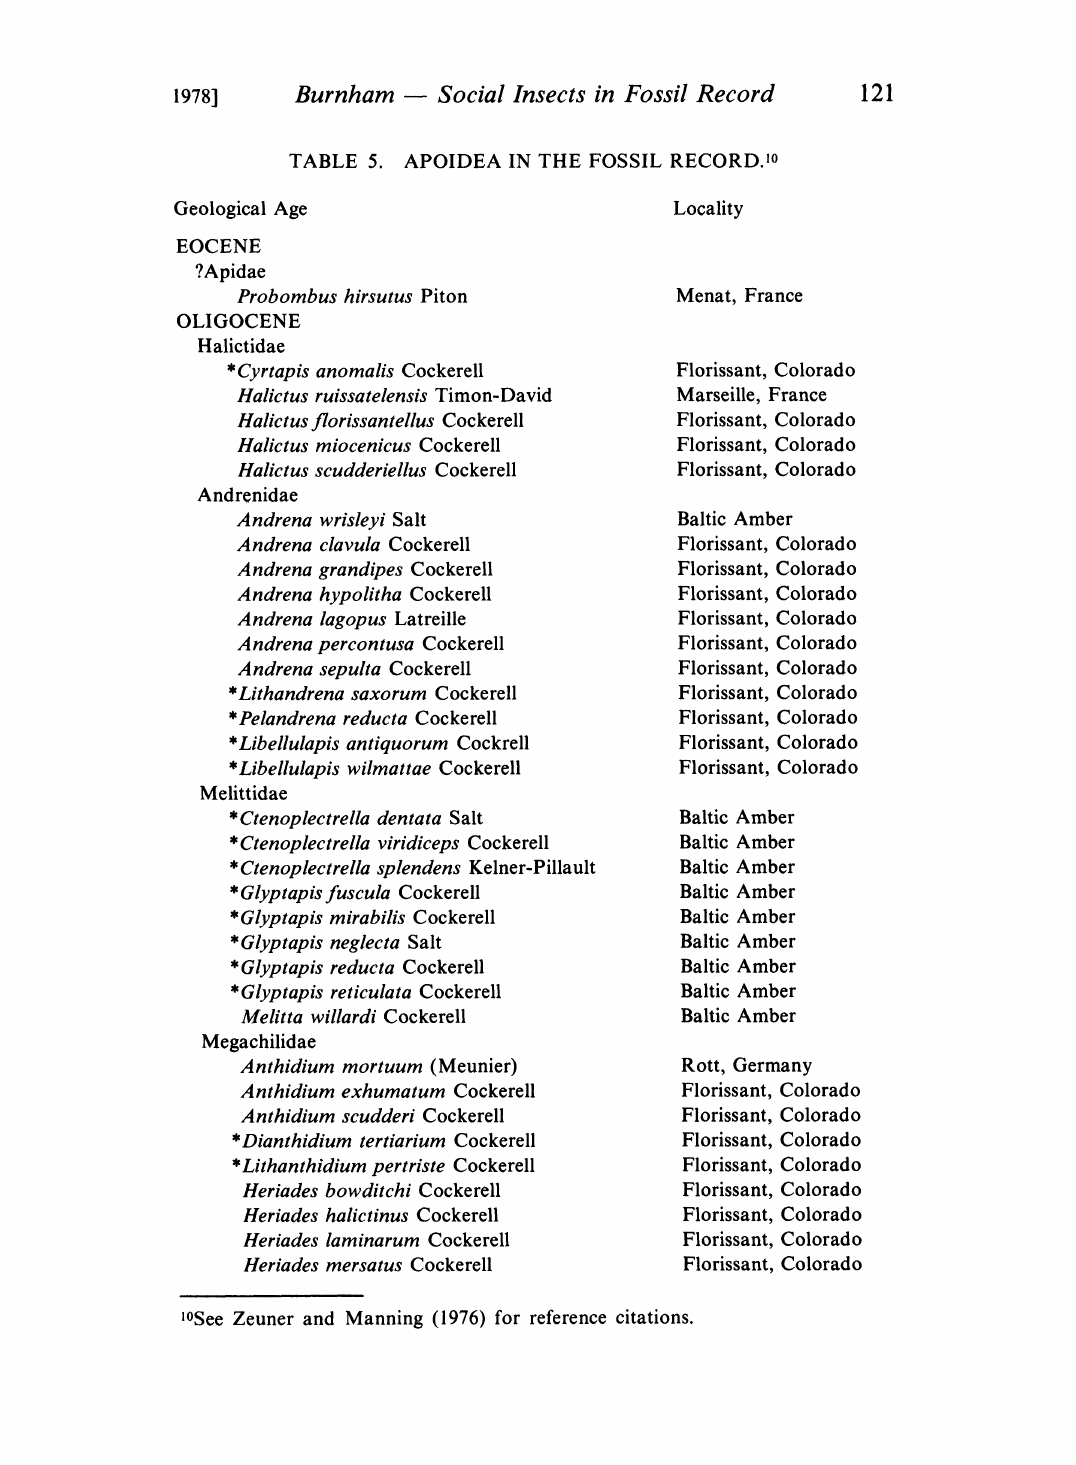
TABLE 5. APOIDEA IN THE FOSSIL